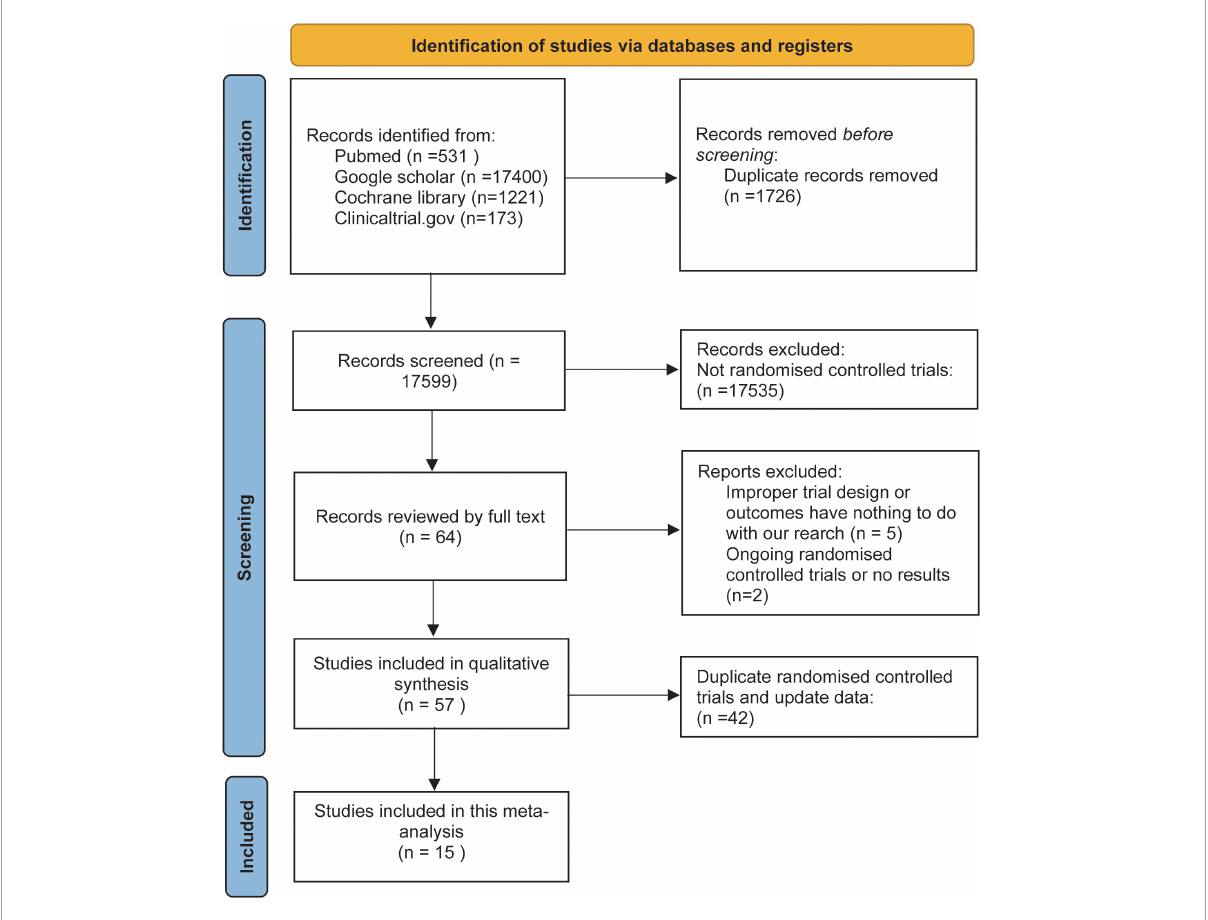
FIGURE1 Flow diagram of the study selection